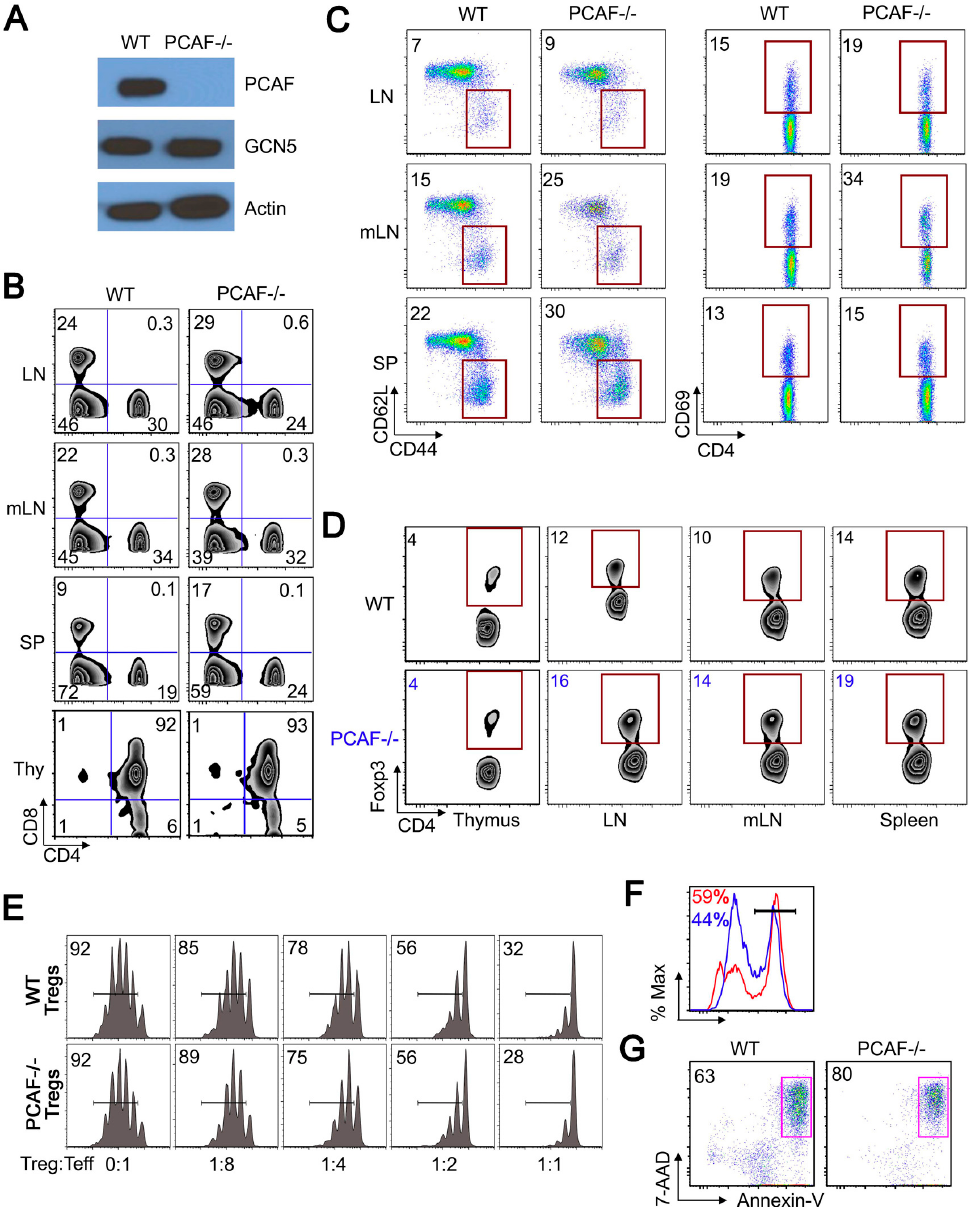
Figure 2. p300 / CBP-associated factor (PCAF) is important for inducible Treg (iTreg) production. ( A ) CD4 + T cells were isolated from WT and PCAF − / − mice and analyzed by Western blotting, with β -actin as a loading control. ( B , C ) Data are from 6-month-old mice. ( B ) Comparison of CD4 + and CD8 + T cell percentages in peripheral lymph nodes, mesenteric lymph nodes, spleens, and thymii of WT and PCAF − / − mice. ( C ) Comparison of percentages of CD44 hi CD62L lo and CD4 + CD69 + cells in WT and PCAF − / − mice. ( D ) Percentages of CD4 + Foxp3 + Tregs in thymii, peripheral lymph nodes, mesenteric lymph nodes, and spleens of WT and PCAF − / − mice. ( E ) CD4 + CD25 + cells were isolated from WT and PCAF − / − mice and incubated with CFSE-labeled WT CD4 + CD25 − Te ff cells, irradiated APC, and CD3 mAb for 3 days; the percentages of proliferating Te ff cells are shown. ( F , G ) CD4 + CD25 hi cells were isolated from WT and PCAF − / − mice and stimulated with CD3 / CD28 mAb-coated beads for 24 h. ( F ) The percentages of Foxp3 + cells are shown, with cells gated on CD4 + ; red indicates WT Tregs and blue indicates PCAF − / − Tregs, p < 0.05 as seen in Figure S7. ( G ) The percentages of apoptotic 7-AAD + Annexin V + are shown, and cells were gated on CD4 + Foxp3 + staining; p = 0.02 as seen in Figure S7. Data are representative of 3 independent experiments.